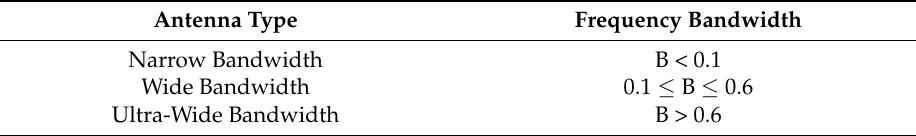
Table 4. Classification of the antenna based on the frequency